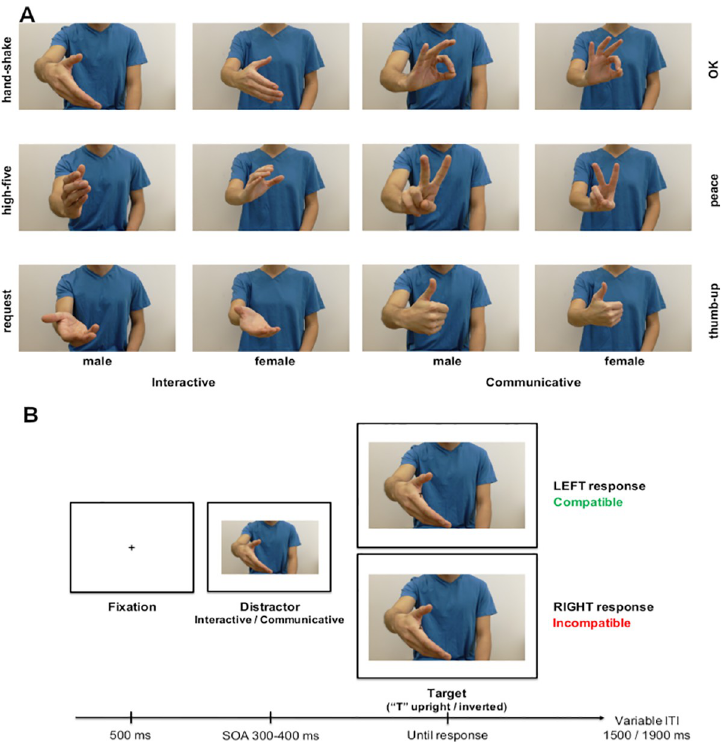
Fig 1. A. The images of the gestures used as distractor stimuli. B. The trial-time line. Both experimental stimuli and trial-timeline were identical in Experiment 1, 2 and 3.